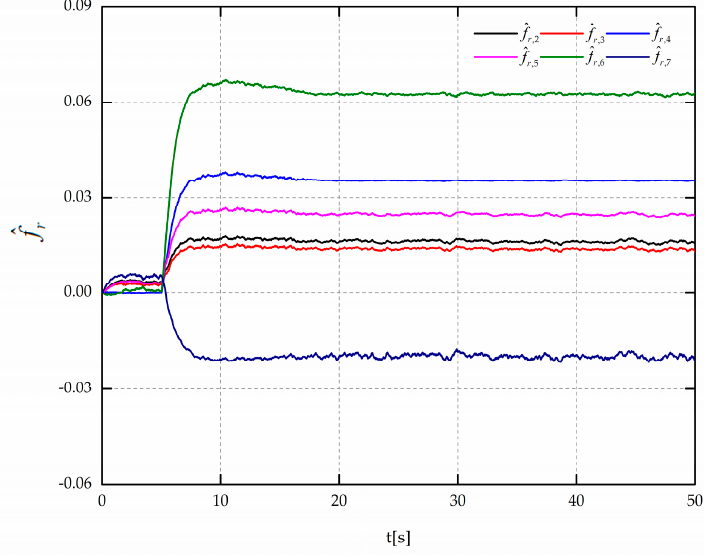
Figure 8. Fault reconstruction generated by SMO1 in Mode 1.